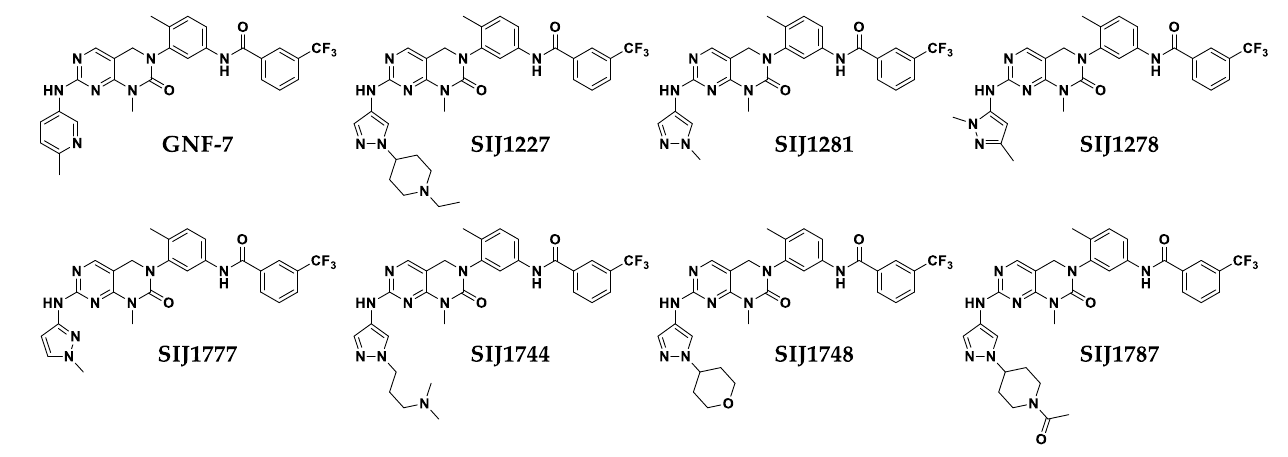
Figure 2. Chemical structures of GNF-7 and its derivatives. Table 1. Anti-proliferative activities of the six GNF-7 analogs against melanoma cell lines harboring BRAF wt or class I/II/III mutants .